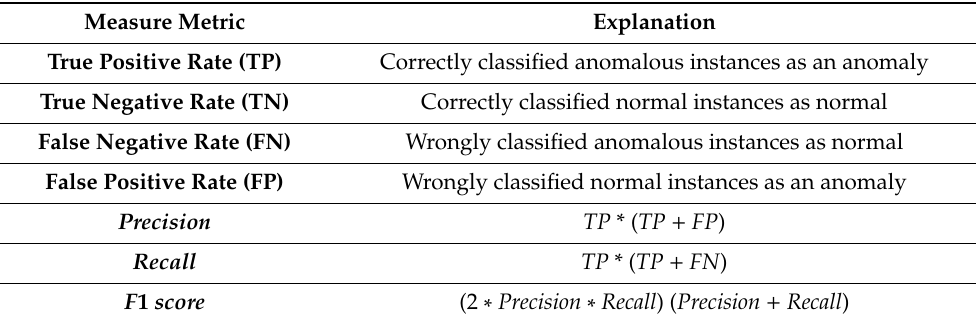
Table 3. Evaluation